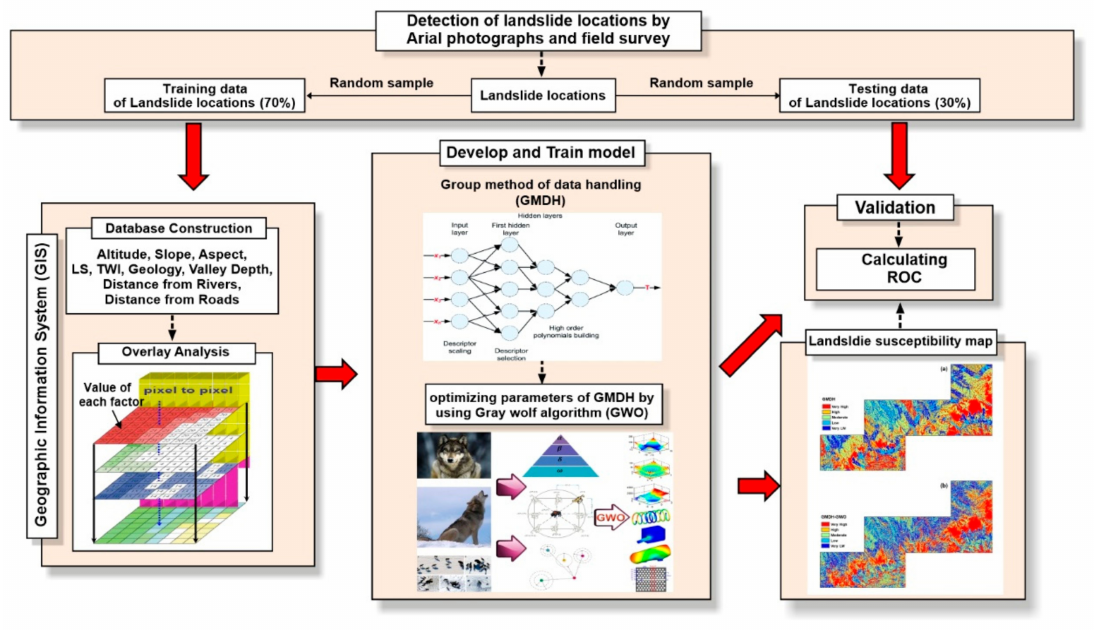
Figure 4. The procedures overview to prepare the landslide susceptibility